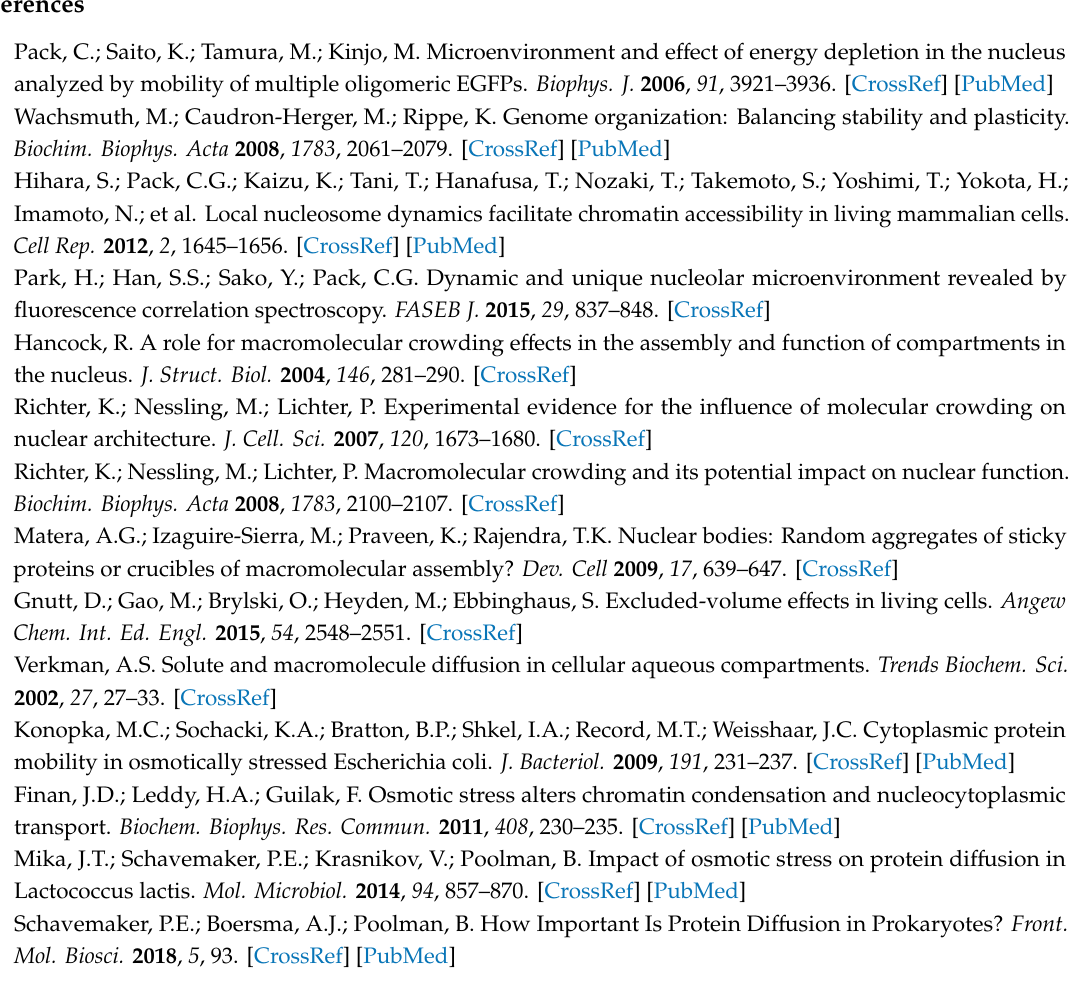
Figure S1: The number of chromatids of a DM cell can be clearly imaged and counted, Figure S2: Influence of osmotic changes on the mean RI and volume of mitotic chromosomes in live DM cells, Figure S3: Structural change of mitotic chromosome observed by 3D reconstruction of confocal images of single DM cells coexpressing H2B-mRFP and mGFP, Figure S4: Influence of osmotic change on nuclear distribution of chromatin of DM cells. Nuclear reorganization by osmotic change was analyzed by using confocal images of single DM cells coexpressing H2B-mRFP and mGFP, Figure S5: Linear relationship between refractive index and viscosity of glycerol–water